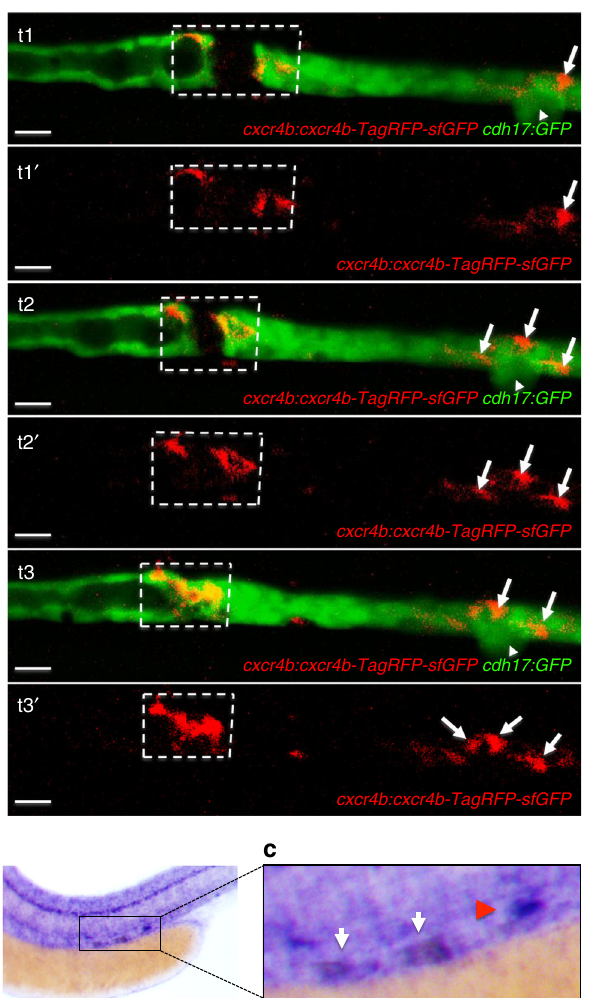
Fig. 5 Cxcr4b expression in response to injury. a The GFP-RFP-tagged Cxcr4b ( cxcr4b:cxcr4b-tFT ) was up-regulated in cells adjacent to the laser- induced injury. The arrowhead points to the corpuscle of Stannius. Arrows point to RFP-positive cells, accumulating distally after the injury. Sequential frames were taken from a time-lapse video at t1 = 96 min, t2 = 120 min, and t3 = 160 min after injury (scale bar, 20 µ m). b In situ hybridization revealed up-regulated cxcr4b expression in the leading ends of the regenerating tubule 2 h after laser-induced ablation. The cxcr4b up- regulation is outlined in a dashed box. Note that cxcr4b is strongly expressed in the corpuscle of Stannius (arrow) and in the lateral line. c Magni fi cation of the injury region depicted in b . The white arrows point towards the up-regulated cxcr4b , the red arrowhead towards the corpuscle of